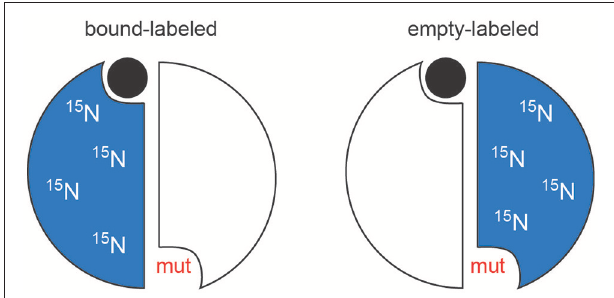
FIGURE 6 | Schematic of mixed labeled dimer (MLD) samples. For simplicity, the mutation is shown in the same protomer as whose active site is compromised. In TS, the mutations are actually made in the opposite protomer’s residues (R126 and